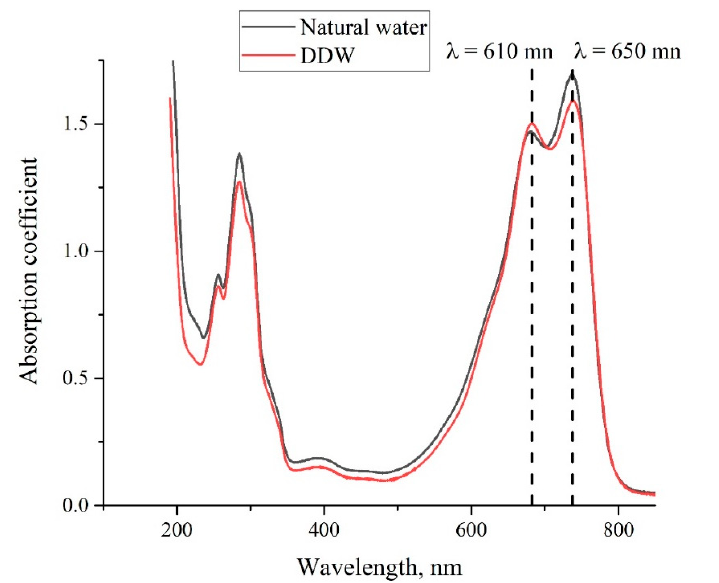
Figure 2. The absorptivity spectrum of dry Nafion.